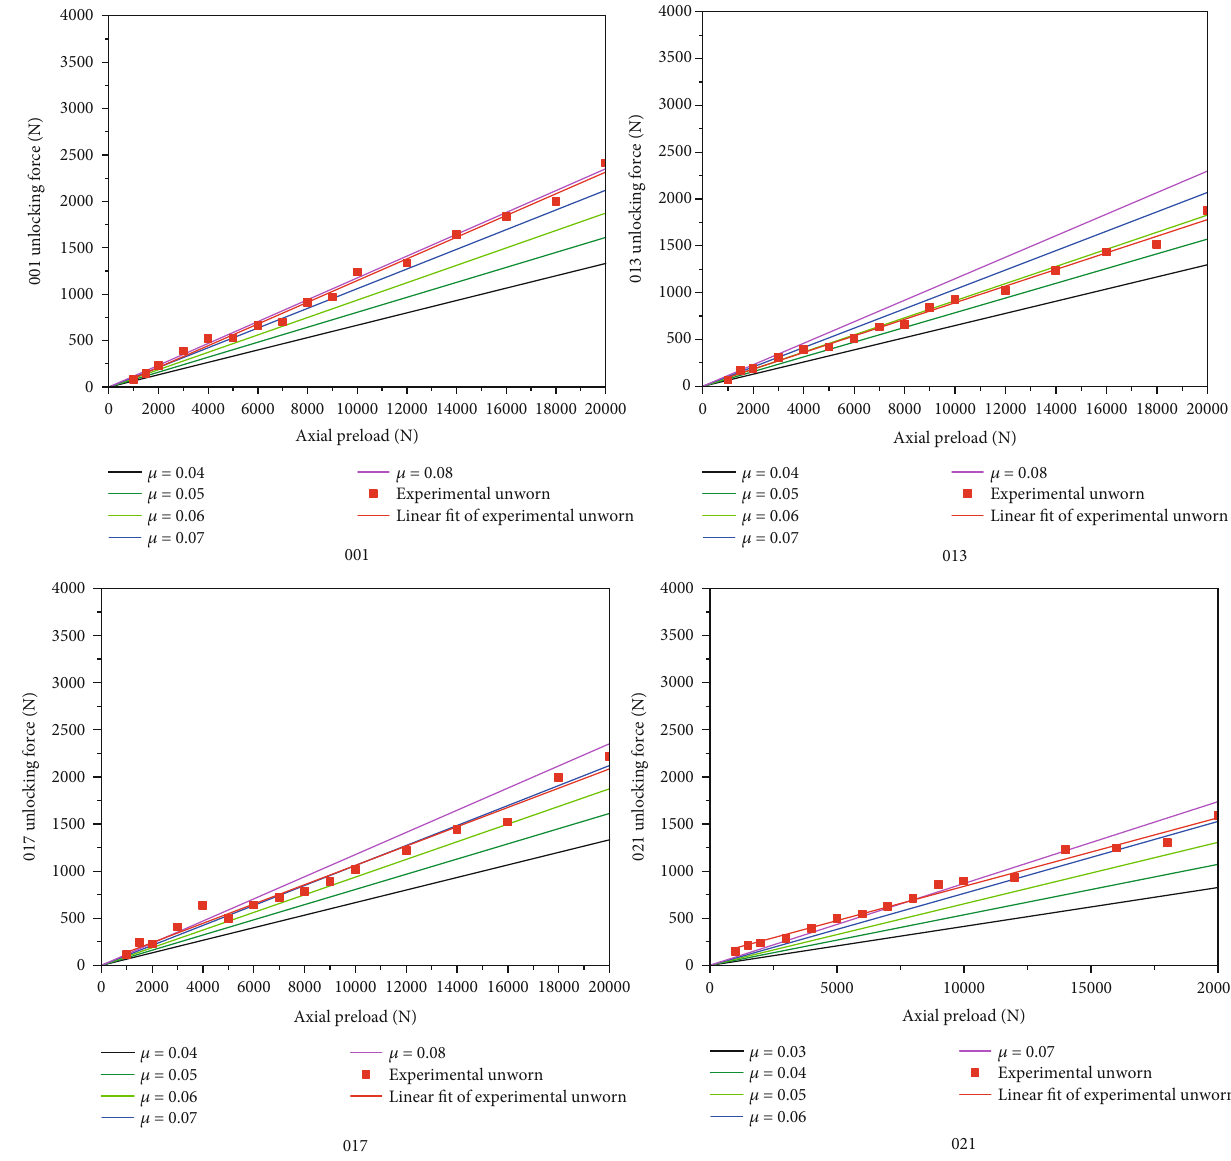
Figure 16: Friction coe ffi cient curve of each fi nger lock with